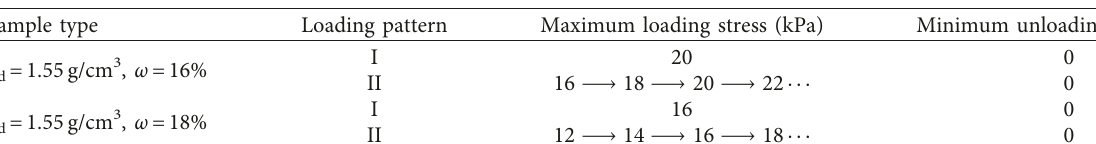
Table 3: Loading histories.